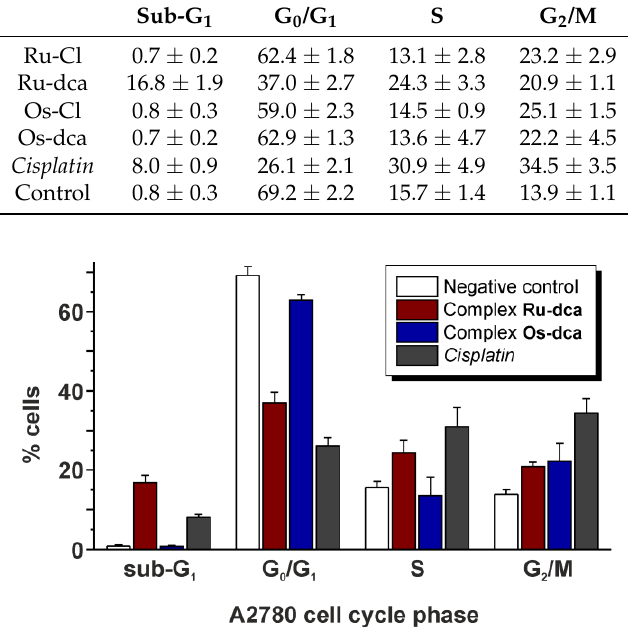
Figure 5. The A2780 cell cycle phase populations (%) after the 24 h treatment by the IC 50 concentrations of complexes Ru-dca and Os-dca , given together with untreated cells (negative control) and the cells treated with platinum-based drug cisplatin . The data are given as arithmetic mean from three independent experiments.